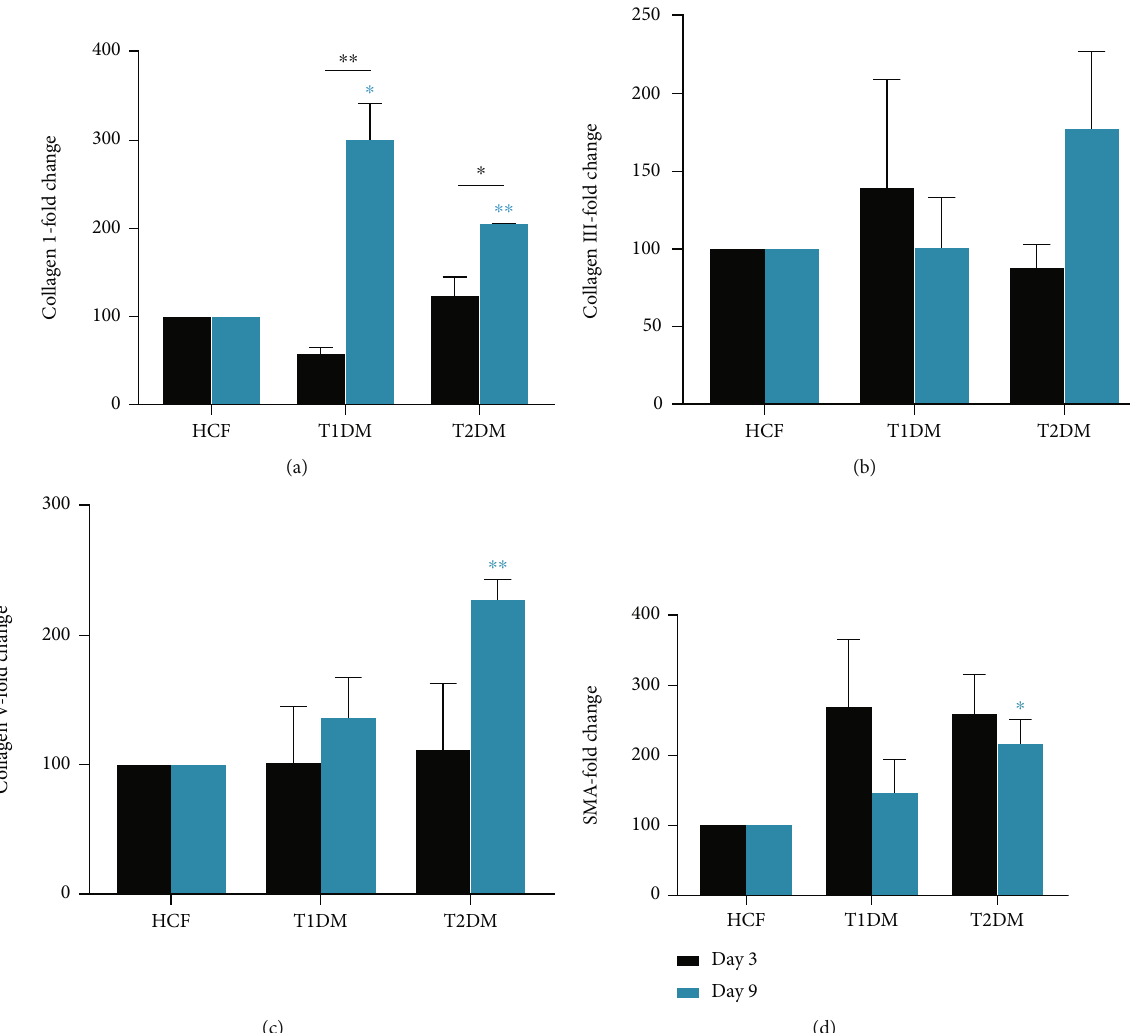
Figure 2: (a) Collagen I (Col I), (b) collagen III (Col III), (c) collagen V (Col V), and (d) α -SMA (SMA) protein levels in HCF, T1DM, and T2DM on days 3 and 9. Col I was signi fi cantly increased on day 9 in the T1DM and T2DM compared to the HCFs and between days 3 and 9. Signi fi cant increases in Col V and SMA were seen at day 9 for the T2DM when compared to HCFs at day 9. Welch ’ s unpaired t -test and/or ordinary one-way ANOVA ( n = 4 ) was used to analyze the results. Error bars represent standard deviation ( ∗∗ denotes p < 0 : 01 and ∗ denotes p < 0 : 05